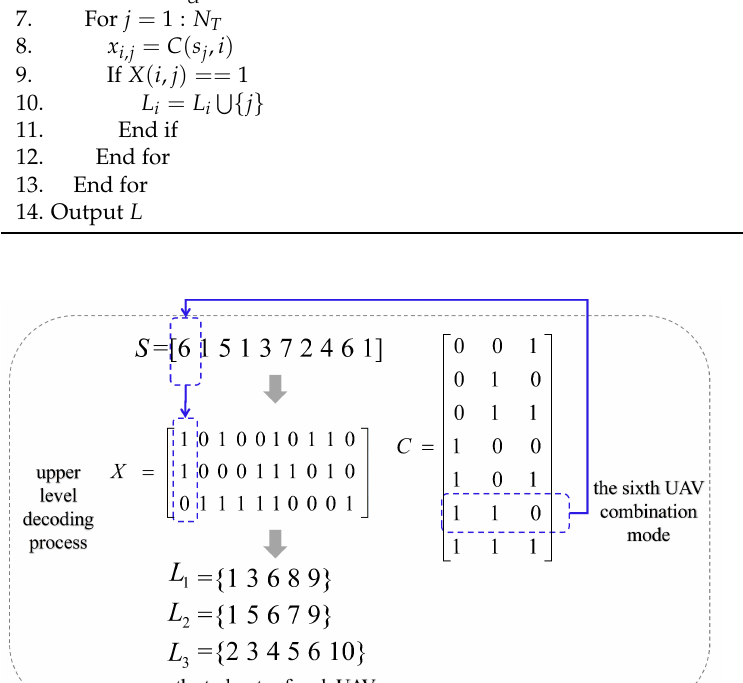
Figure 3. The decoding process of the upper level of the example of three UAVs and ten tasks.